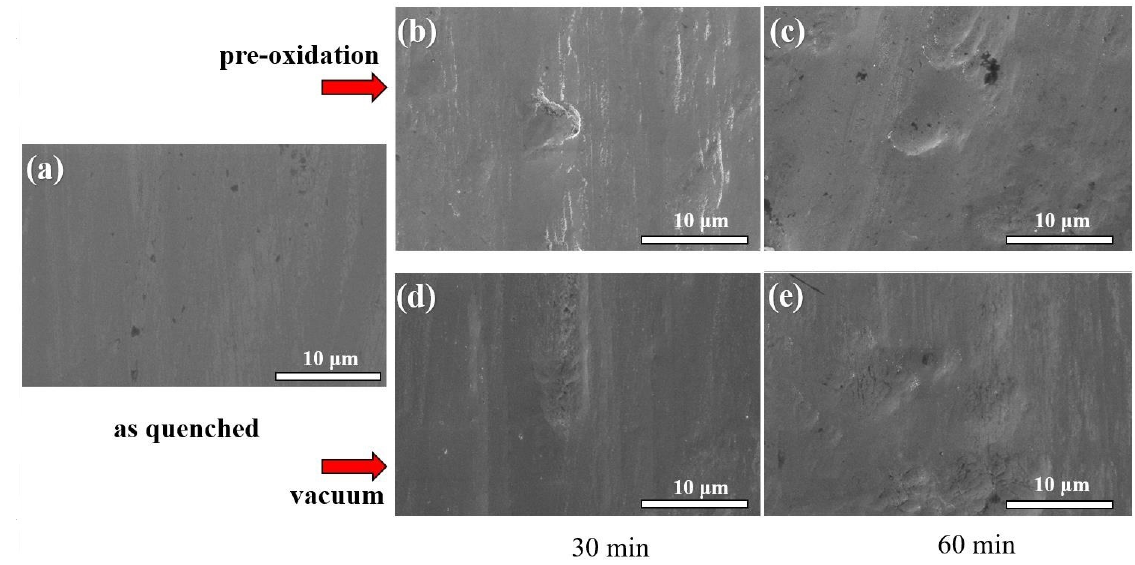
Figure 5. The surface morphologies after heat treatment at 280 °C for different times. ( a ) as- quenched, ( b ) pre-oxidated for 30 min, ( c ) pre-oxidated for 60 min, ( d ) vacuum heat-treated for 30 min, ( e ) vacuum heat-treated for 60 min.